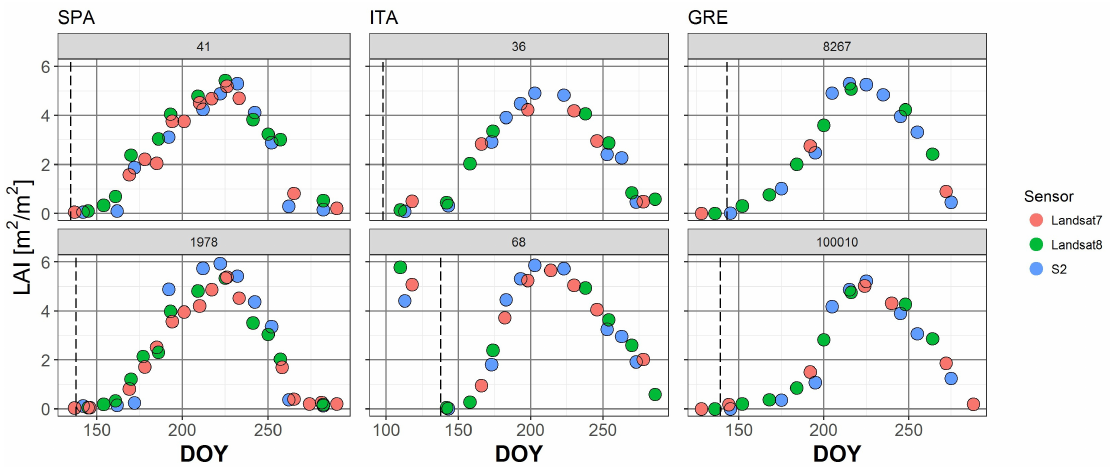
Figure 6. Example of merged series of LAI on three sites. Dotted vertical bars indicate the sowing date. Numbers indicate fields ID. For the sake of visualization, standard deviations are not